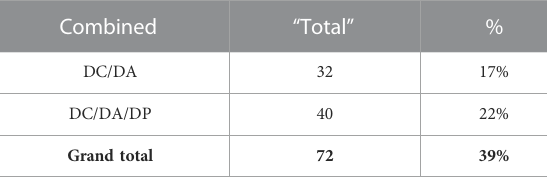
TABLE 6 Distribution of data stages in combined technologies.